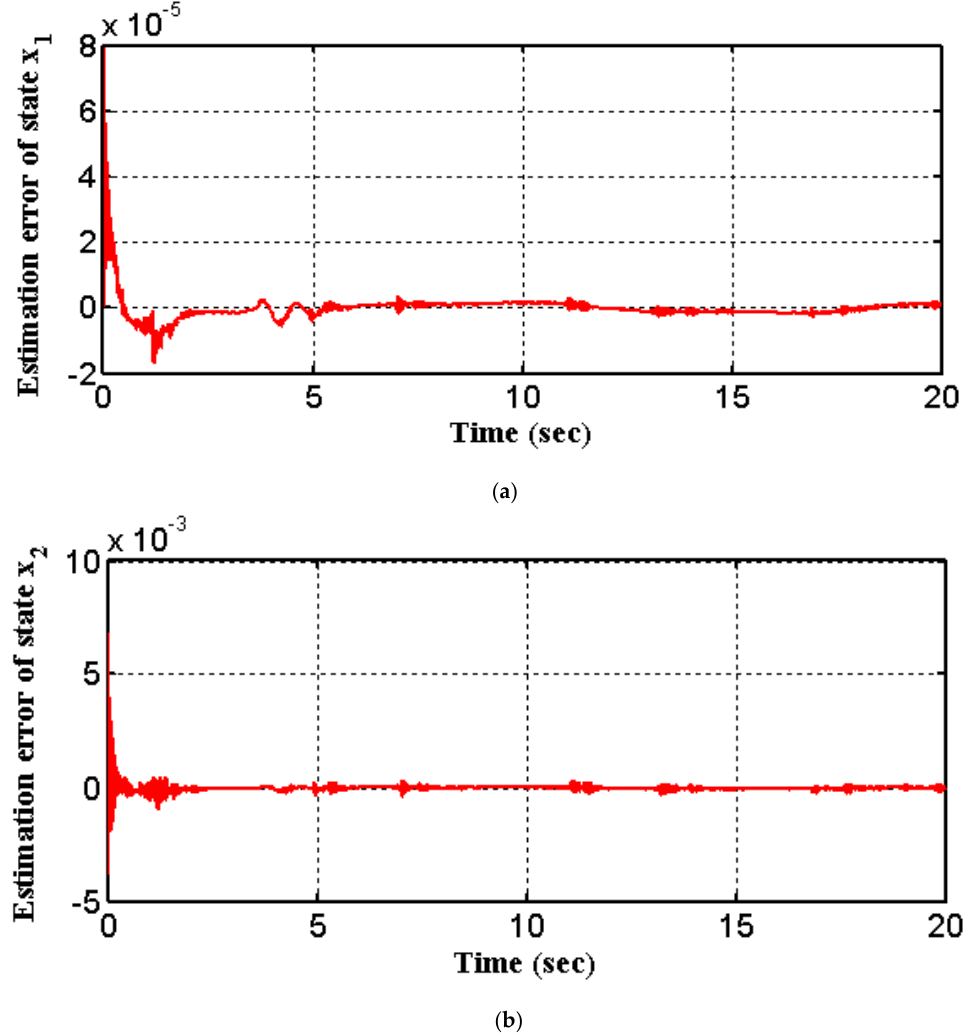
Figure 9. Estimation errors without measurement noise using C-ADRC, ( a ) e 1 ( b ) e 2 .